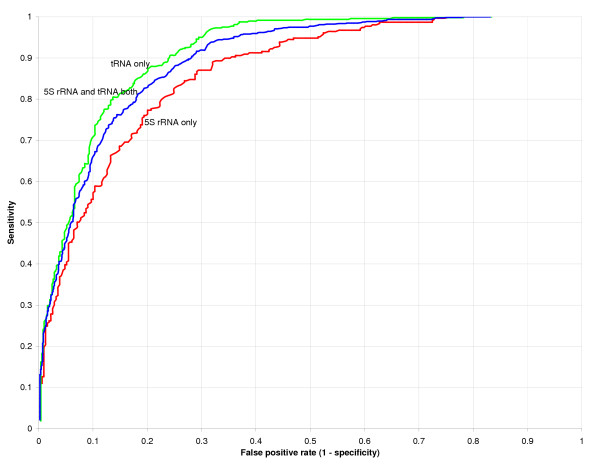
Quality of classification using the z score method for single sequences. ROC curves showing quality of classification based on single sequences, using RNAstructure-predicted z scores for folding free energy change. The ncRNA sequences and controls are the same as in Figure 1. Red and green show results for 5S rRNA and tRNA, respectively, when tested separately; blue shows results when both are combined into a single test set.